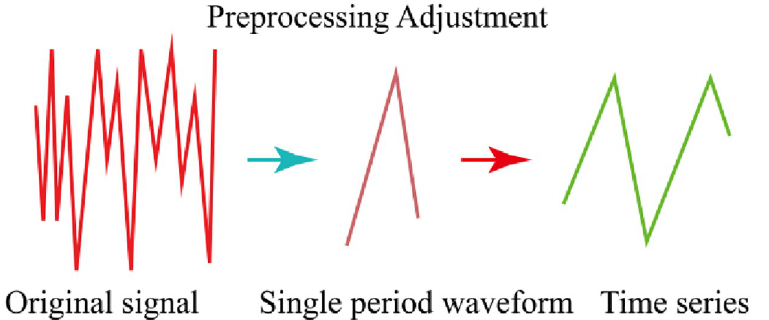
Fig 2. The extraction process of time